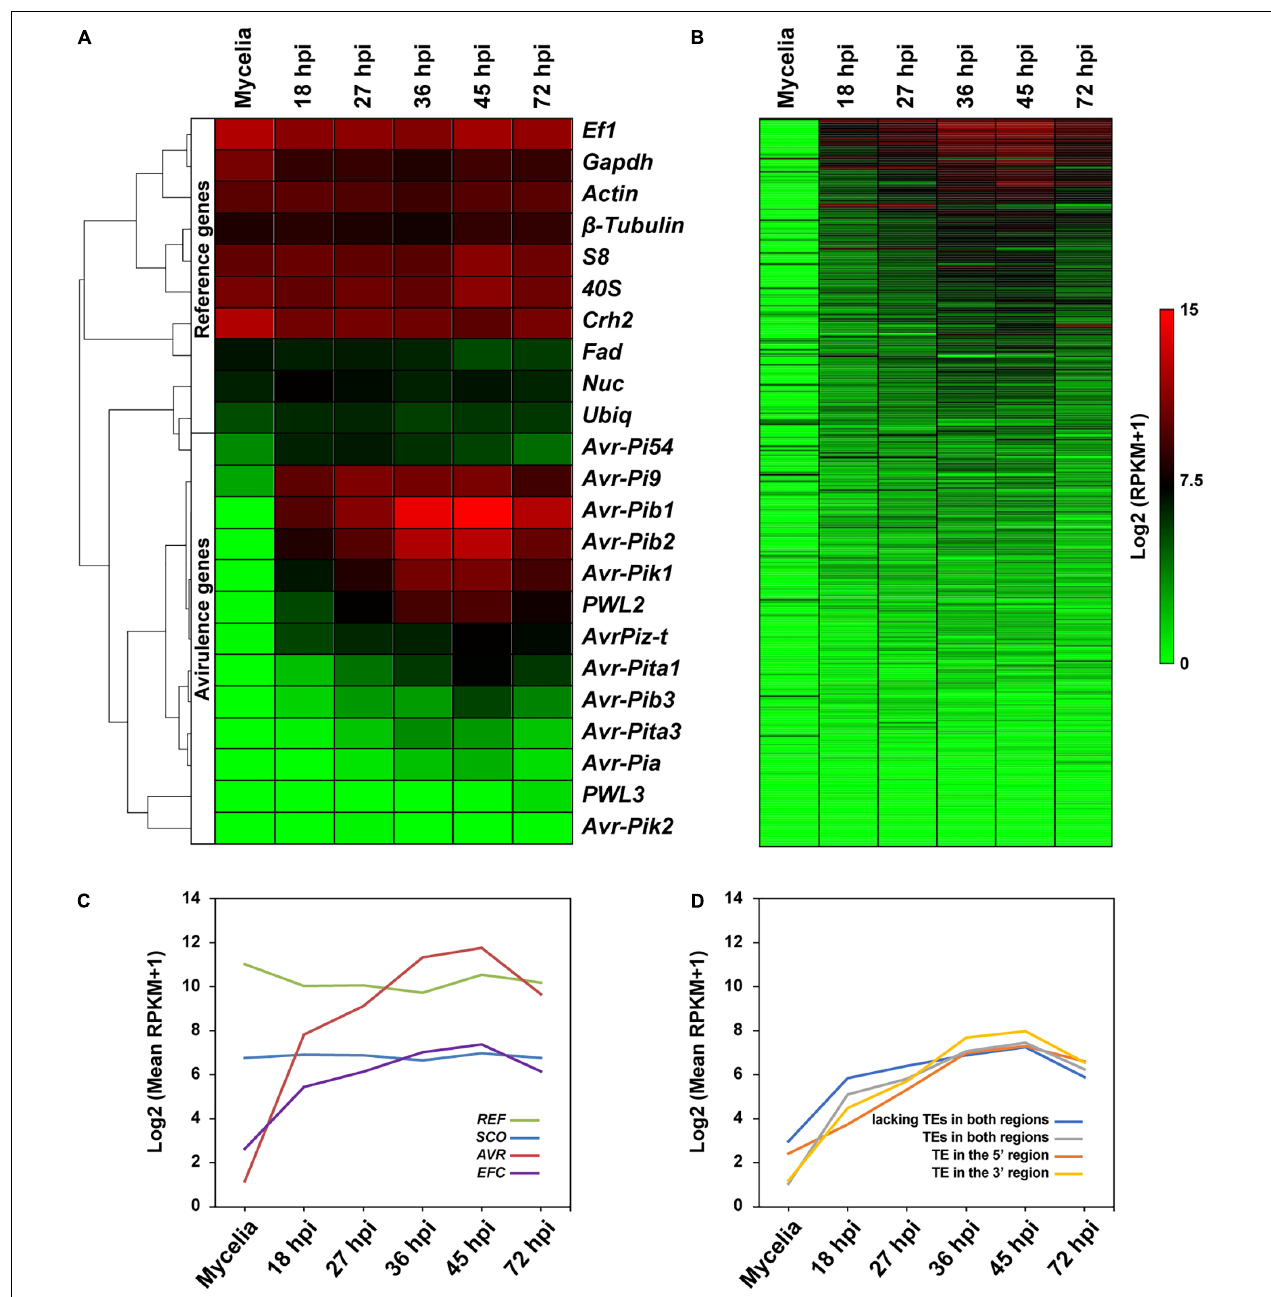
FIGURE 7 | Comparative analysis of the expression patterns of the REF , AVR , EFC, and SCO genes in MoO isolate KJ201. Expression patterns of (A) REFs and AVRs and (B) EFCs in KJ201 in mycelia and during rice infection are shown. Data from the samples collected at the pre-penetration (18 hpi), biotrophic growth (27–36 hpi), and necrotrophic (45–72 hpi) stages are shown. (C) Averaged expression patterns of the four gene sets are shown. (D) Averaged expression patterns of the following types of EFCs are shown: those with TEs in both the 5 (cid:48) and 3 (cid:48) regions, those with TEs in the 5 (cid:48) region only, and those with TEs in the 3 (cid:48) region only, and those lacking TEs in both